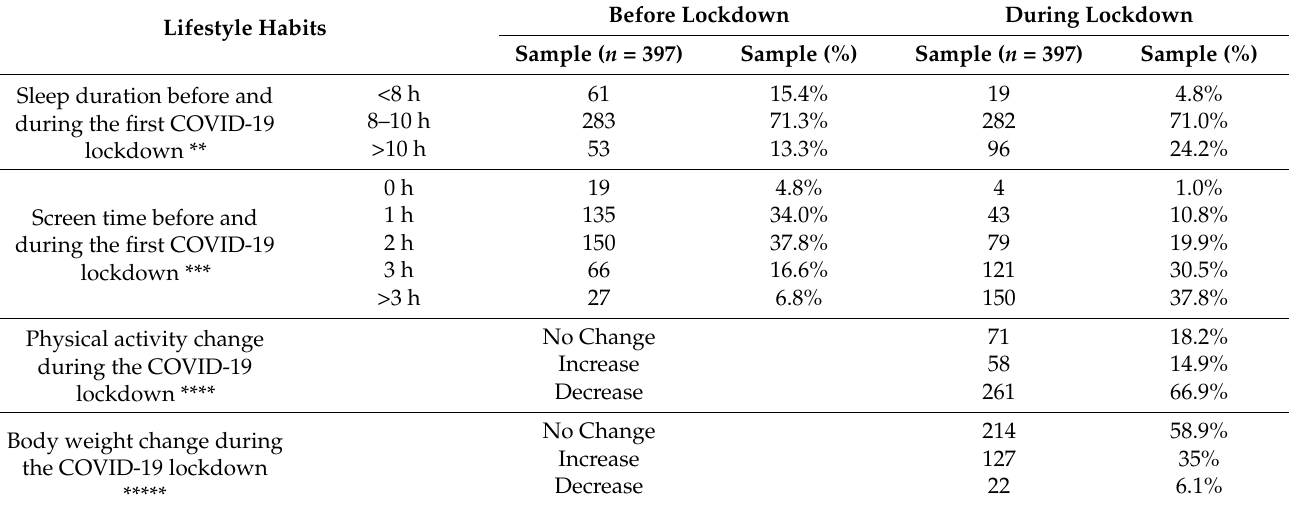
Table 3. Changes of children’s and adolescents’ lifestyle habits * and body weight in the first coronavirus disease 2019 (COVID-19) lockdown in Greece. The COV-EAT